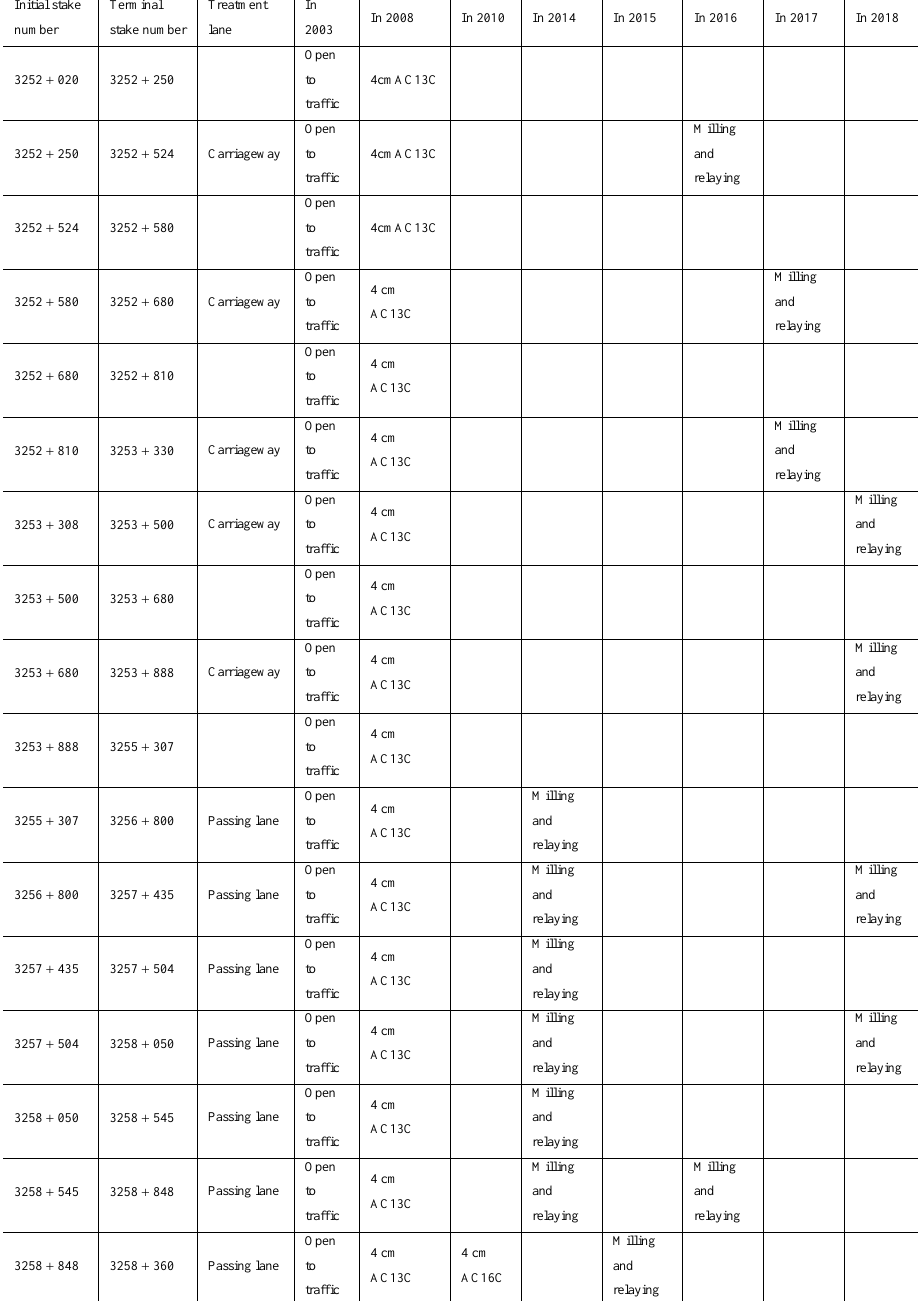
Table 2 History of the attention and maintenance of K3252 + 020 ∼ K3258 + 360 section of the expressway with a reconstruction and extension in Guangdong